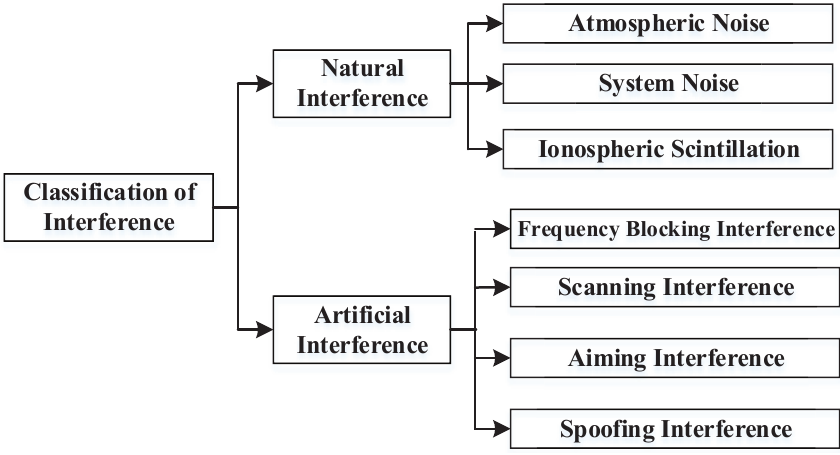
Figure 4. Electromagnetic interference